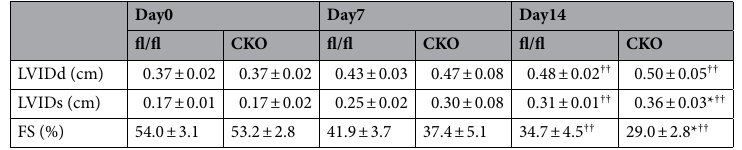
Table 1. Cardiac functions of Runx2 fl/fl and Runx2 CKO mice after MI. LVIDd = left ventricular internal dimension at diastole; LVIDs = left ventricular internal dimension at systole; FS = fractional shortening. Data are shown as mean ± SD (Runx2 fl/fl mice: n = 5, Runx2 CKO mice: n = 6). * P < 0.05 vs Runx2 fl/fl at Day14 by Student’s t -test, †† P < 0.01 vs Day0 by Dunnett test.